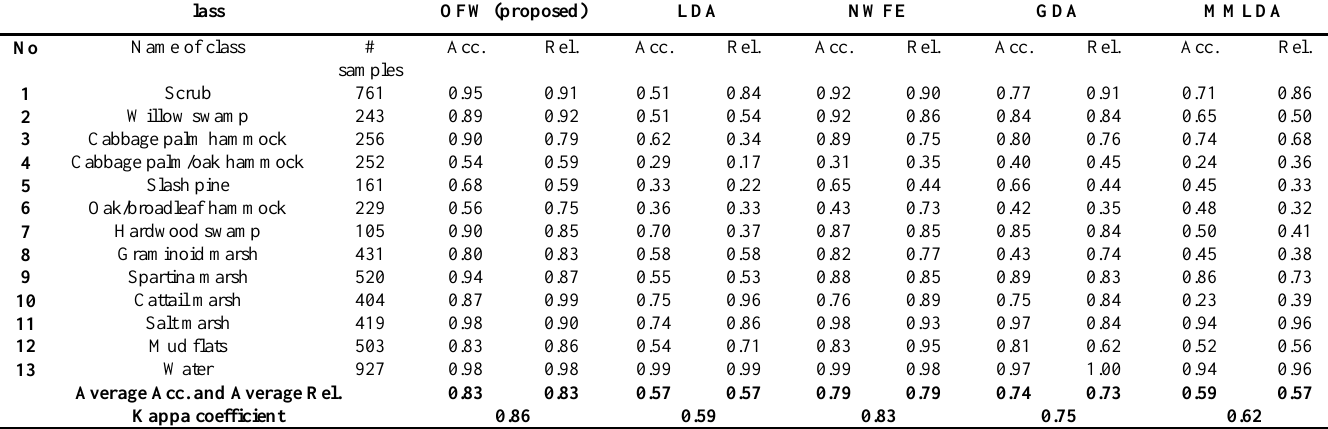
Table 3. Accuracy and reliability of classes of KSC dataset obtained by SVM classifier and 10 extracted features.